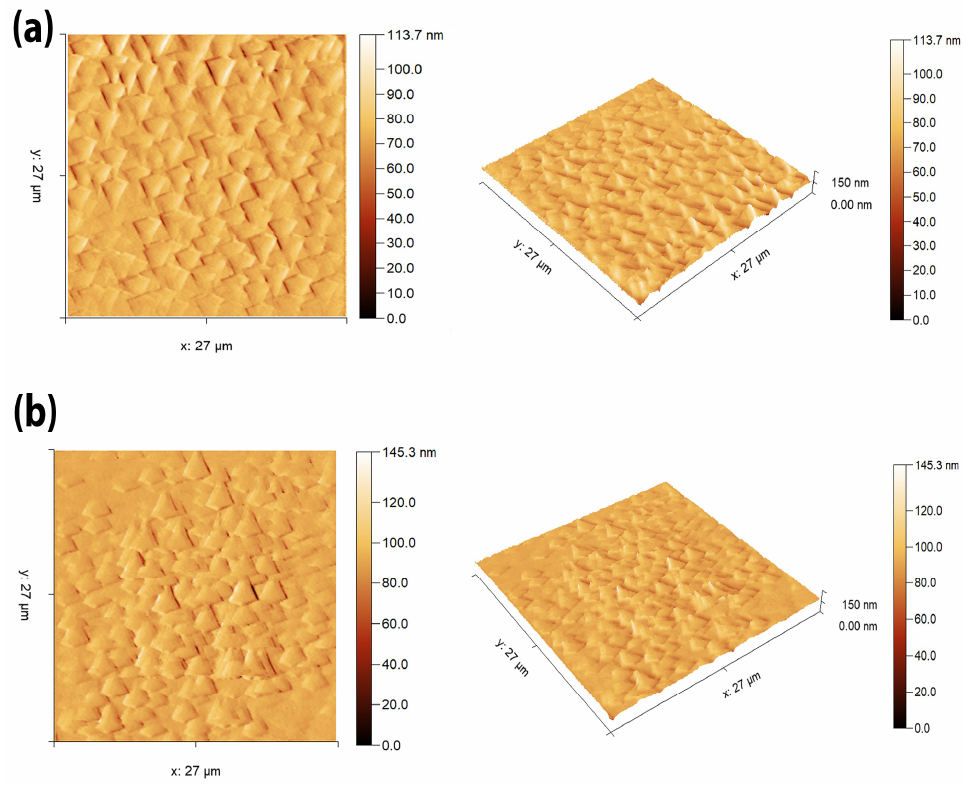
Figure 2. AFM images of ( a ) P3HT and ( b ) P3OT samples.